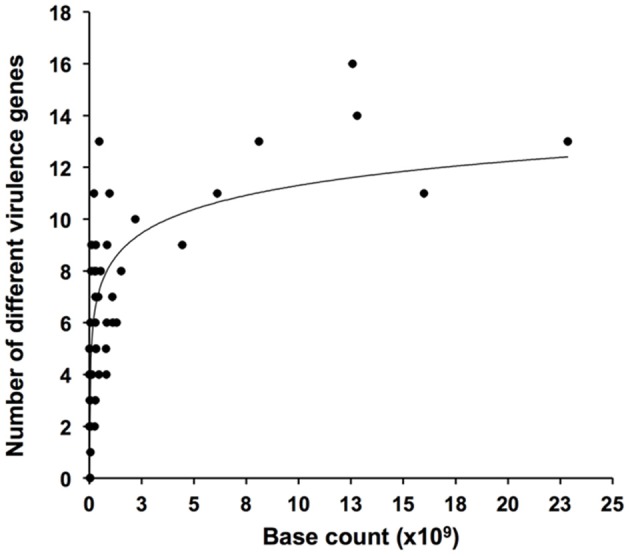
Rarefaction plot showing numbers of detected virulence genus as function of size (numbers of bases sequenced) of metagenomic datasets.